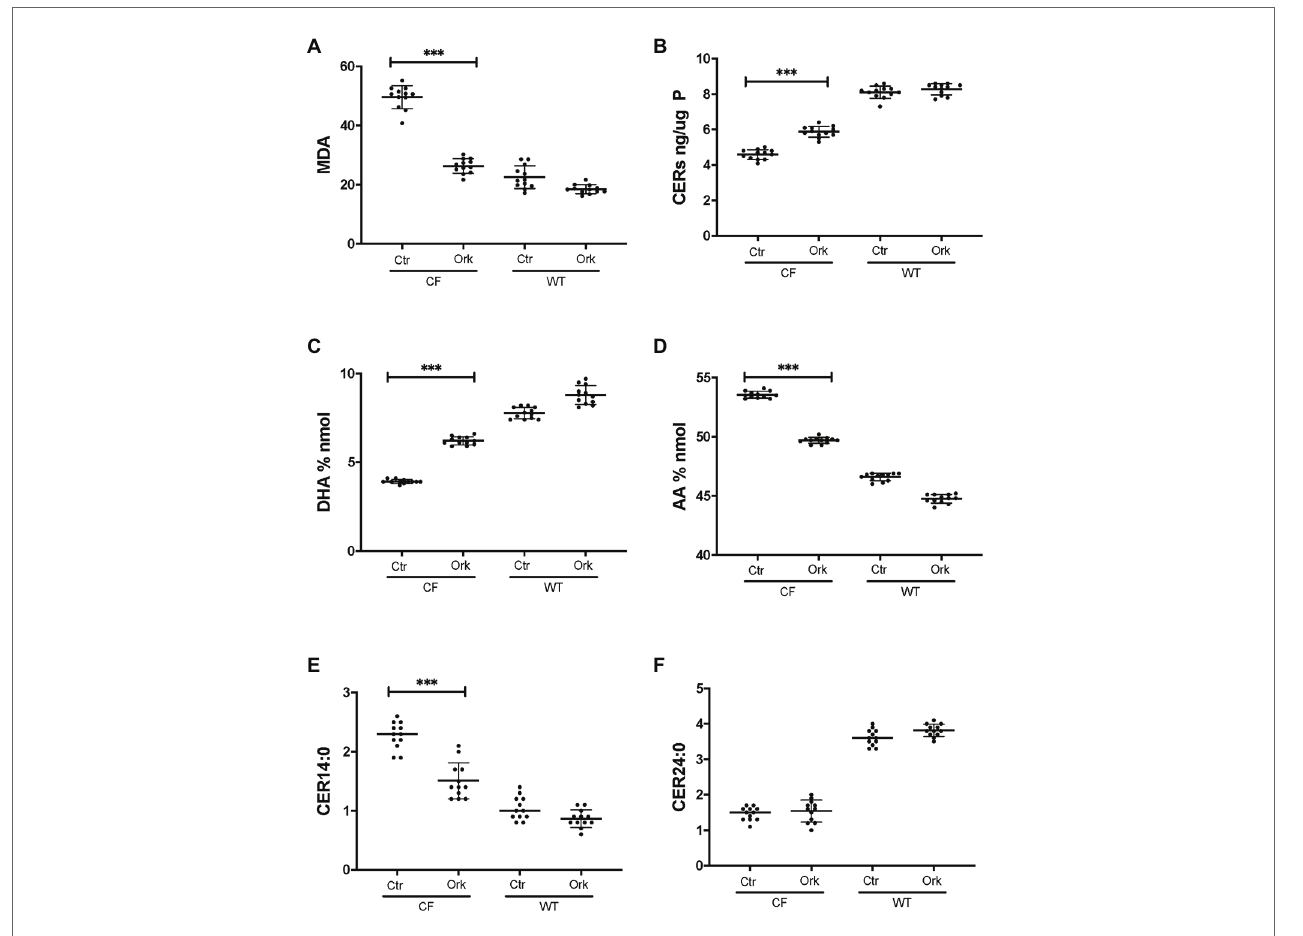
FIGURE 5 | Partial correction of oxidative stress and lipid imbalance in CF HBEC-ALI by ivacaftor/lumacaftor. Treatment of the high responder ( Table 1 ) homozygous F508del CFTR BCF174 HBEC ALI with VX-809 (2 μ M) and VX-770 10 nM for 24 h (Ork) causes partial correction of lipid imbalance, compared to carrier control (Ctr; N = 12). Non-CF (WT) cells are represented by three donors in quadruplicate each ( N = 12). (A) malondialdehyde (MDA) pmol/nmol fatty acid. (B) Total ceramides in CF HBEC-ALI. (C) DHA levels (% nmol total fatty acids). (D) AA levels (% nmol total fatty acids). (E) Long-chain ceramide (CER14:0). (F) Very long-chain ceramide (CER24:0) both expressed as pmol/nmol phosphate. Most relevant comparisons are indicated (unpaired ANOVA, Dunnet, *** p < 0.001, untreated CF as